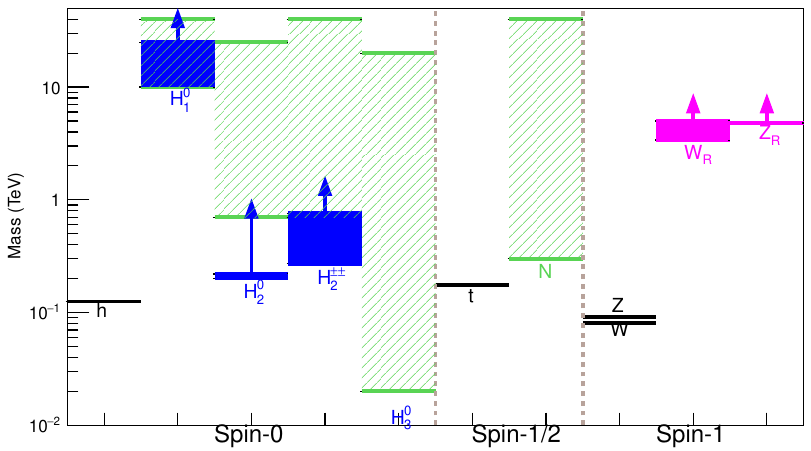
and N in the right panel of figure 6 , H 0 , H ±± , H 0 1 2 3 2